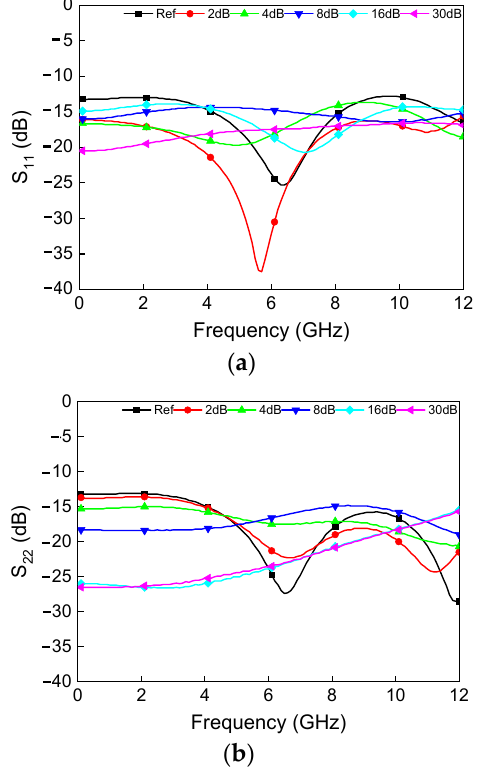
Figure 7. Measured ( a ) S 11 , and ( b ) S 22 of the GaN digital step attenuator MMIC.